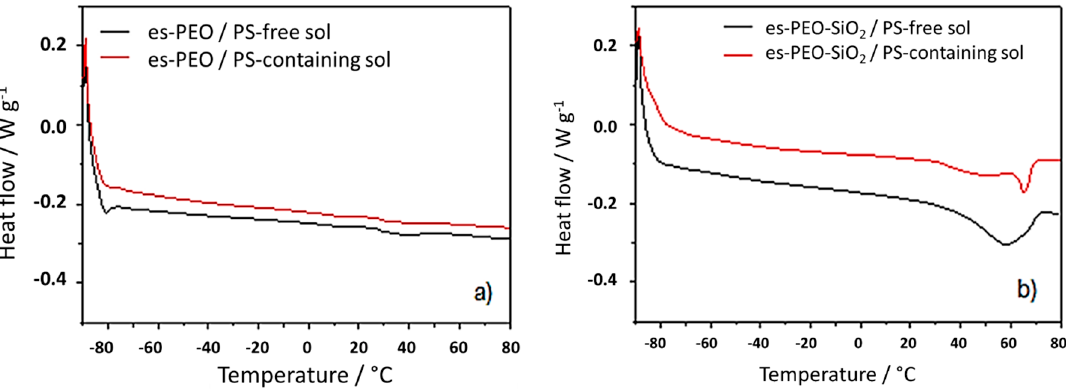
Figure 4. Heating scan of the DSC response of additive free PEO membrane ( a ) and of silica-added PEO membrane ( b ) gelled using liquid electrolyte “PS-free sol” (black curves) or “PS-containing sol” (red curves).